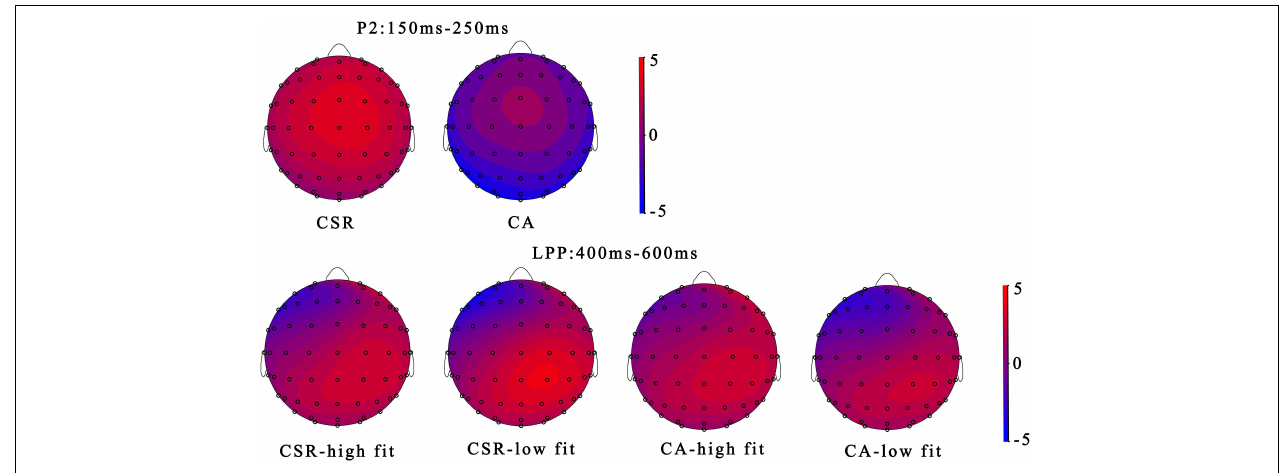
FIGURE 4 | The scalp topographic distributions of the conditions at the P2 time window of 150–250 ms and LPP time window of 400–600